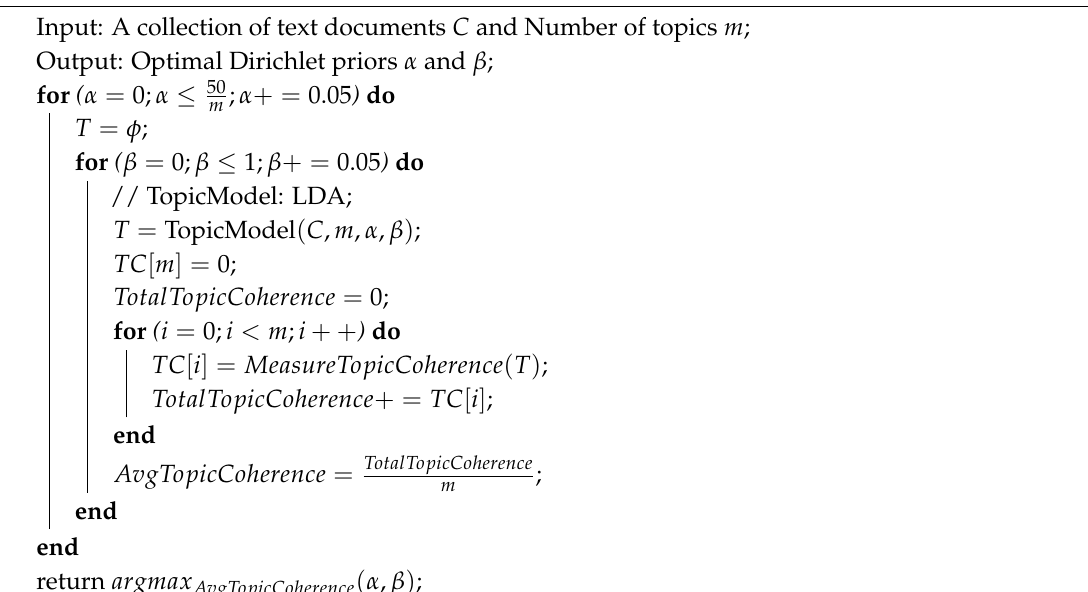
Algorithm 1: The empirical approach for identifying best